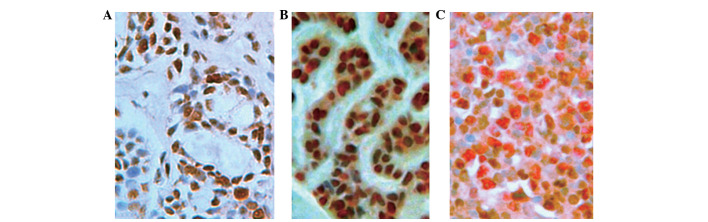
Expression of PCNA and co-expression with HSPs in salivary gland malinant tumors. (A) In adenoid cystic carcinoma, higher PCNA-PI was located in the nucleus of tumor cells. (IHC-SP staining; magnification, ×400). (B) PCNA (AP-Red staining indicated by bright red color) and HSP86 (DAB staining indicated by brownish yellow color) co-located in the nuclei of tumor cells (IHC-Dou SP staining; magnification, ×400). (C) PCNA (AP-Red staining indicated by bright red color) and HSP27 (DAB staining indicated by brownish-yellow color) were respectively located in the nuclei and plasma of same or different tumor cells, with reverse expression trend (IHC-Dou SP staining; magnification, ×400). PCNA, proliferating cell nuclear antigen; HSP, heat shock protein; PCNA-PI, proliferating cell nuclear antigen-proliferating index.